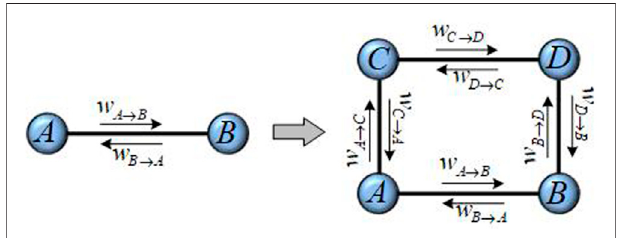
FIGURE 1 | DWEI transformation of edge e = AB .